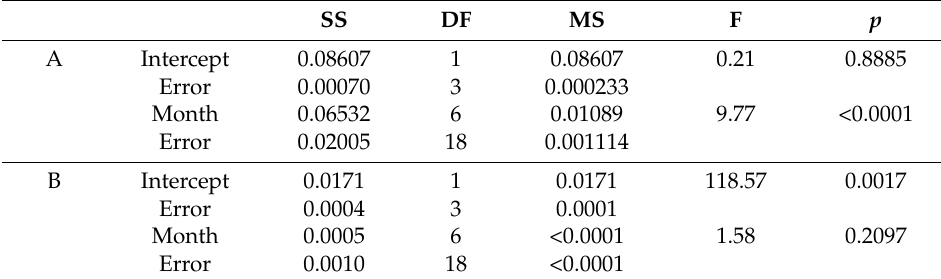
Table 3. Repeated measures ANOVA of (A) the mean antisettlement activity of propan-2-ol surface extract from Z. marina against four different bacteria ( B. aquimaris , A. stellipolaris , L. rosea , and P. dokdonensis ) and (B) rosmarinic acid concentrations on Z. marina surfaces. Within-measures factor was the month of sampling.